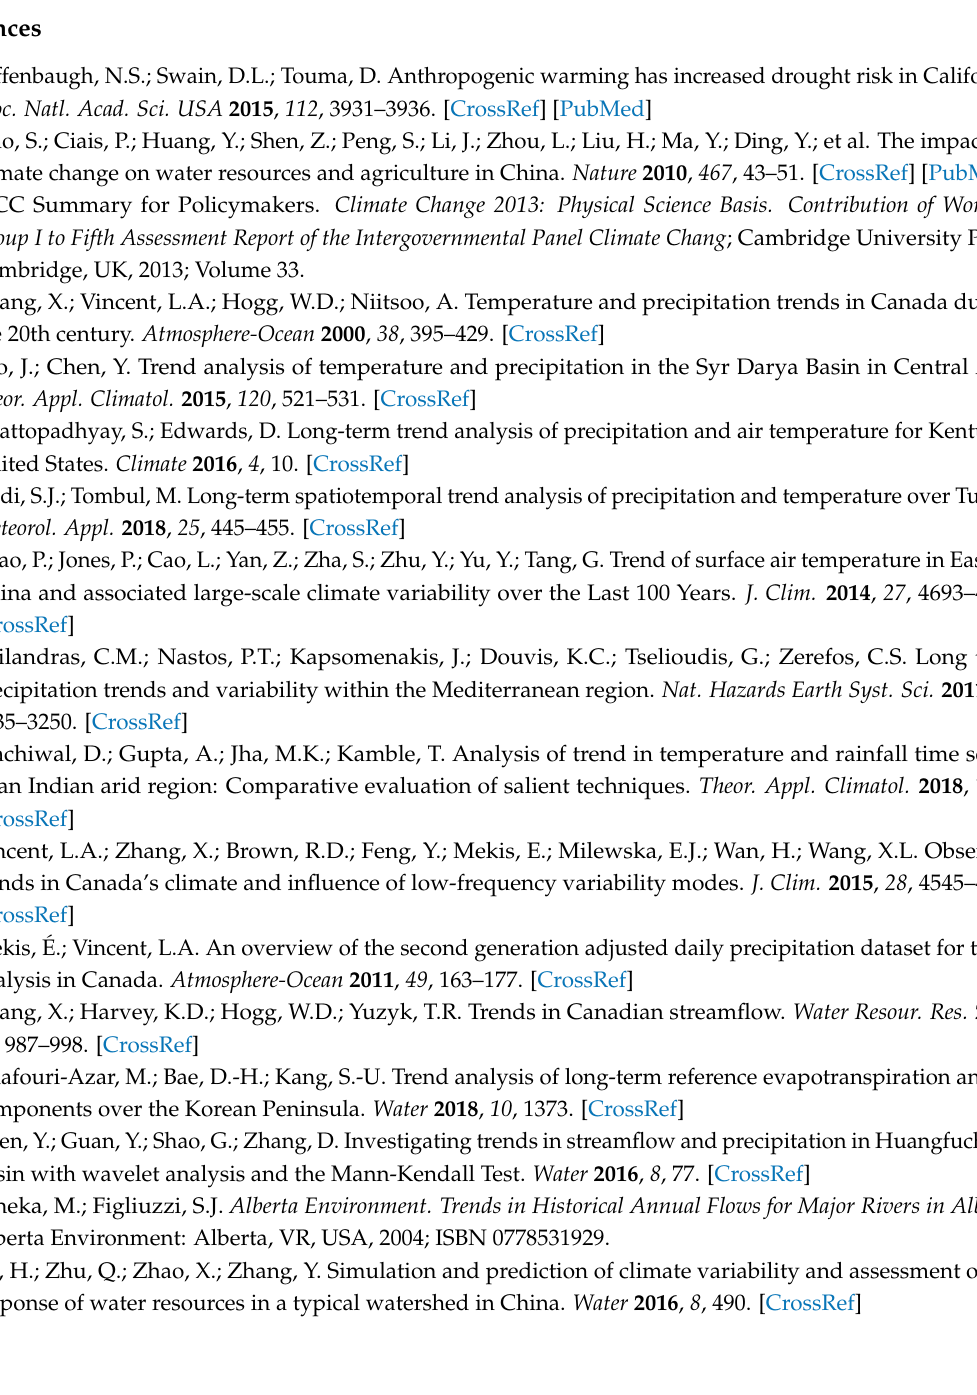
map, Figure S4: Spatial distribution of water yield under RCP 2.6 and 8.5 scenarios, where His indicates historical period (1983–2007), NF indicates near future (2010–2034), and FF indicates far future (2040–2064). For the historical period simulated WYLD is shown in the map, and for the NF and FF difference of WYLD is shown in the map, Figure S5: Long-term average monthly (a) deep aquifer recharge and (b) water yield in the study area and seven selected